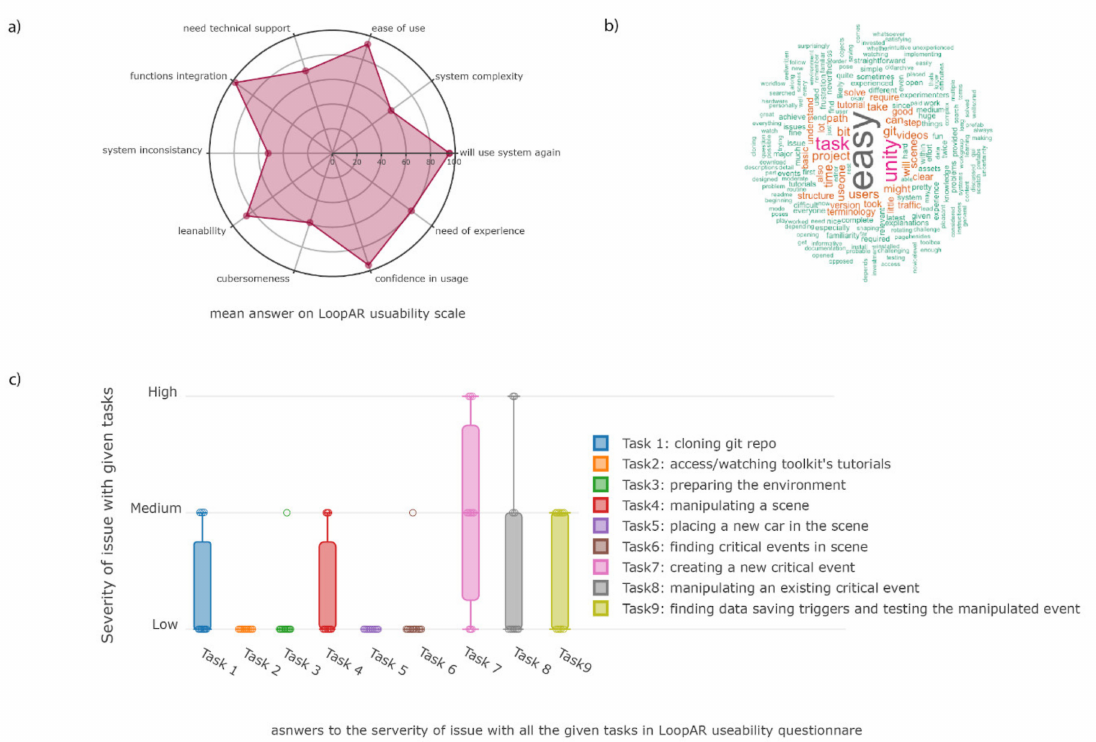
Figure 6. Visualization of the usability report items: ( a ) a radar plot of the system usability scale data; ( b ) a word cloud showing most frequently used words in the comments; and ( c ) a severity of issue bar plot, related to the tasks in the usability report. Low equals no delay in time or perceived obstacles, medium refers to a completed task with added effort. High indicates noticeable delay or frustration and that the participant may not be able to complete the